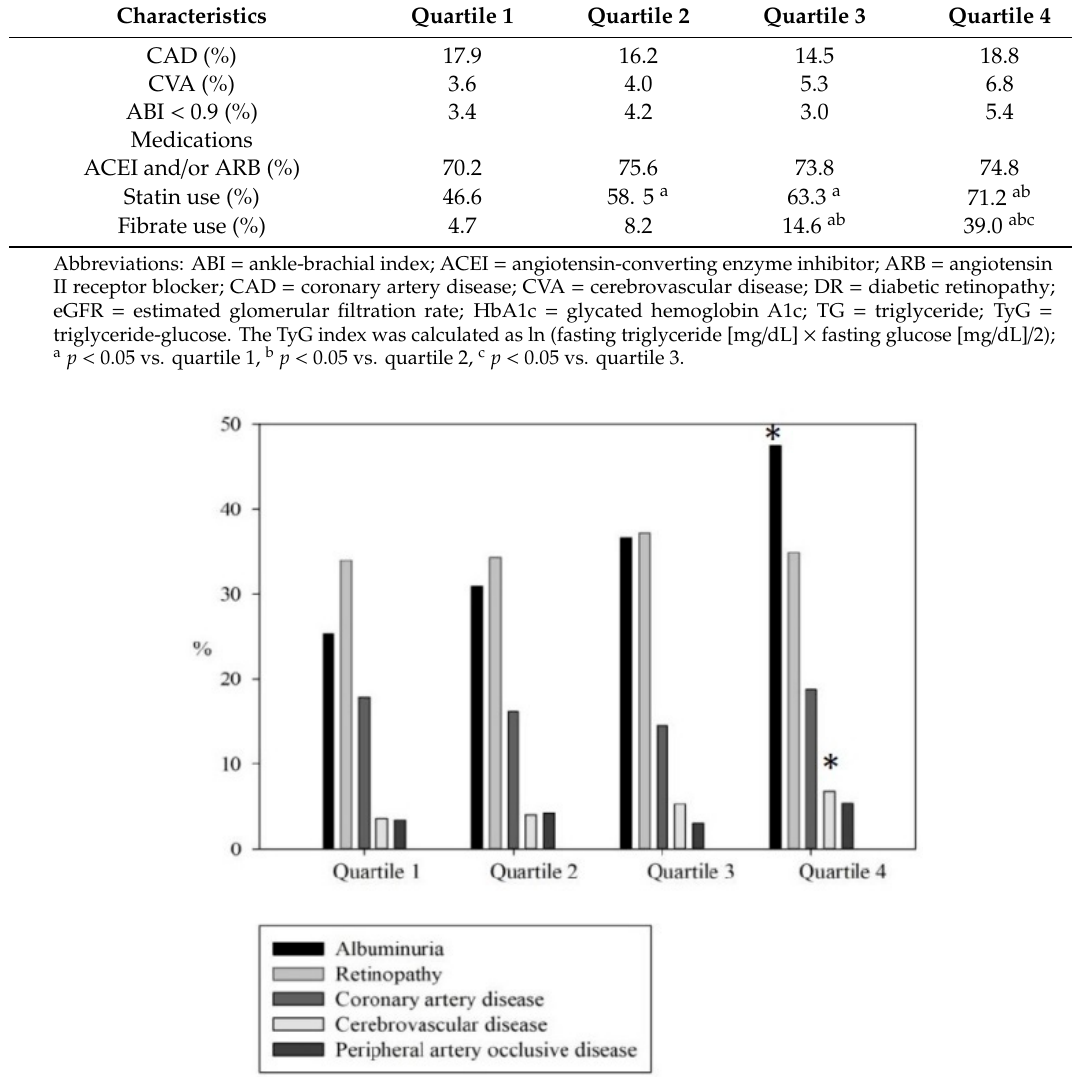
Figure 2. There were significant trends for stepwise increases in albuminuria ≥ 30 mg / g ( p for trend < 0.001) and cerebrovascular disease ( p for trend = 0.013) corresponding to quartiles of TyG index, but not diabetic retinopathy ( p for trend = 0.573), coronary artery disease ( p for trend = 0.880), and peripheral artery occlusive disease ( p for trend = 0.223).